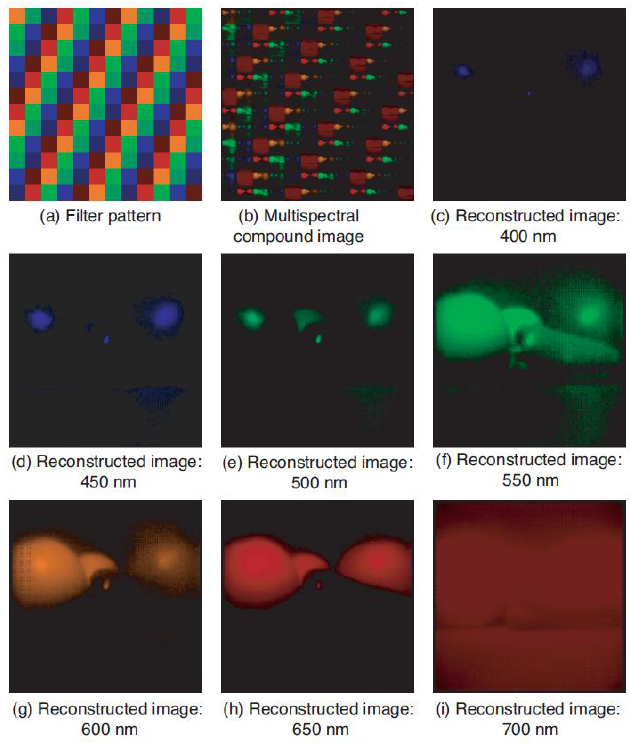
Figure 15. Experimental results obtained from MSI using the prototype TOMBO system.